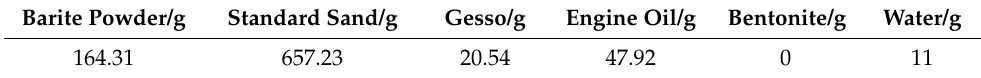
Table 2. Physical and mechanical indexes of test soil samples.